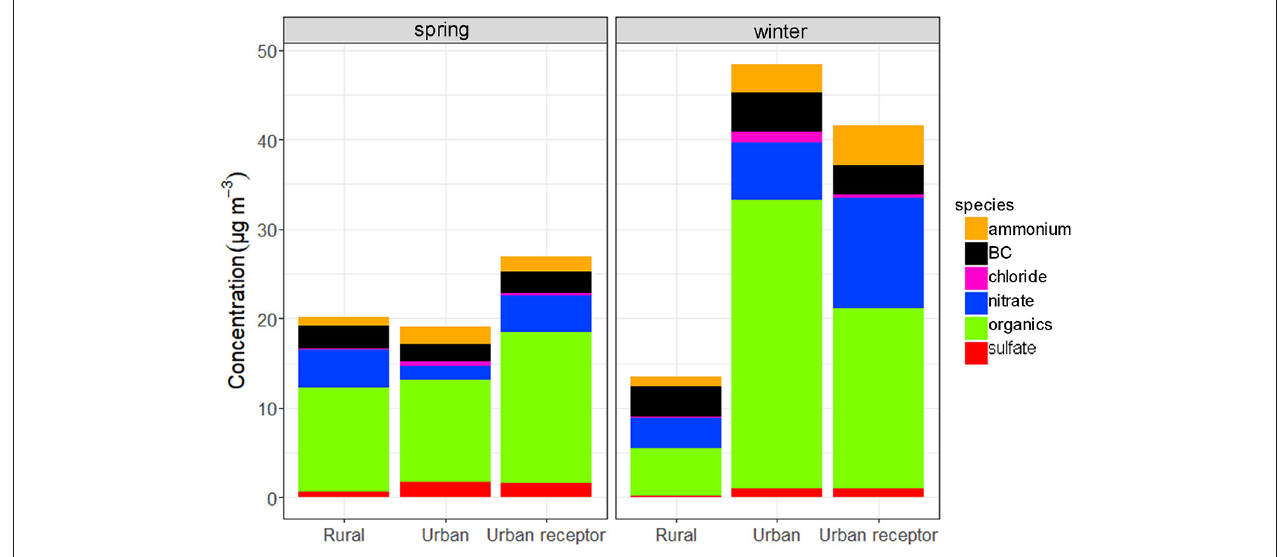
FIGURE 4 | Chemical composition of submicron particle during winter and spring. Seasonal 1-h average concentrations.